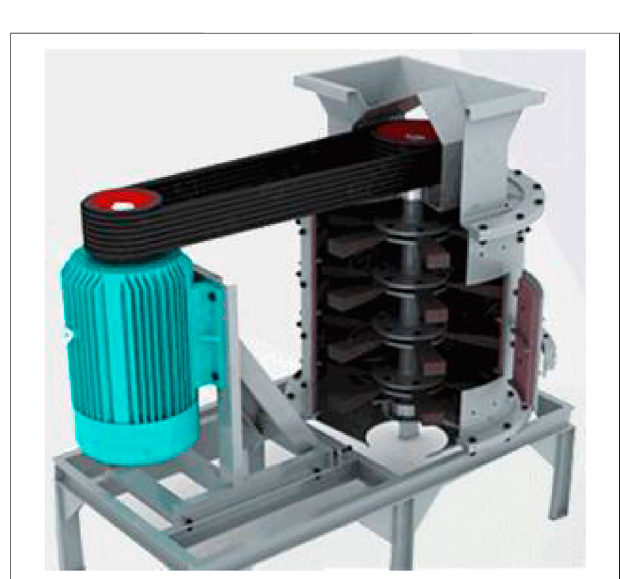
FIGURE 9 | Vertical impact